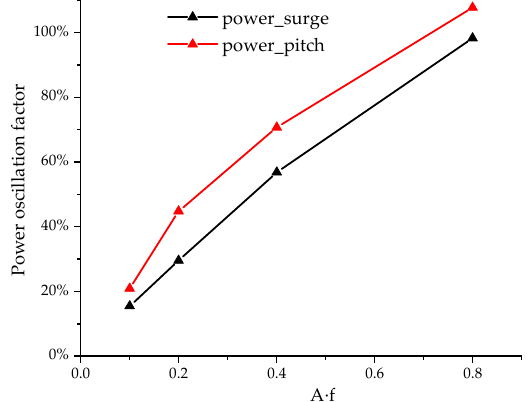
Figure 10. Power oscillation factor versus motion intensity.